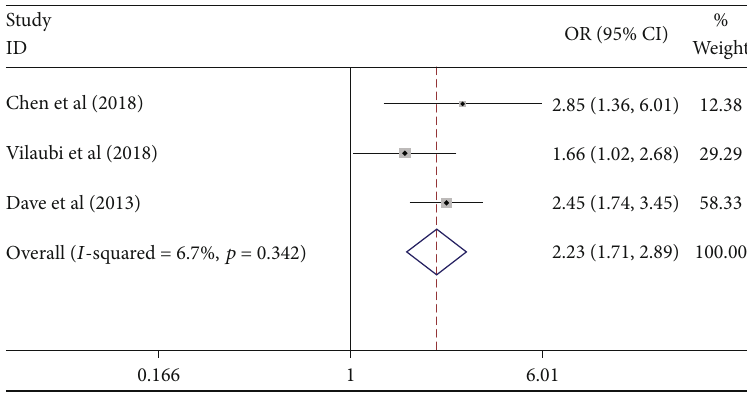
Figure 2: E ff ect size of medication nonadherence on the uncontrolled